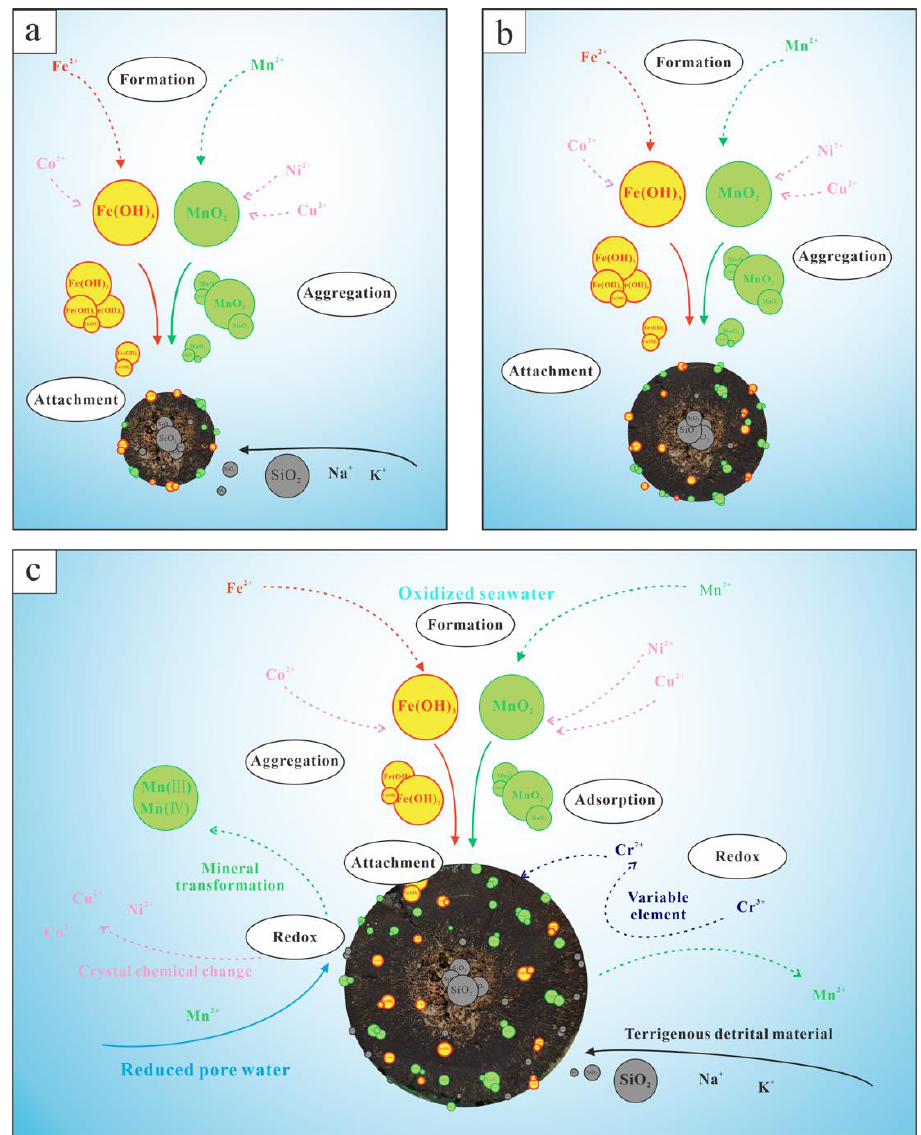
Figure 11. Schematic diagram of the growth stages of polymetallic nodules in the Western Pacific Ocean. ( a ) the first stage; ( b ) the second stage; ( c ) the third stage.